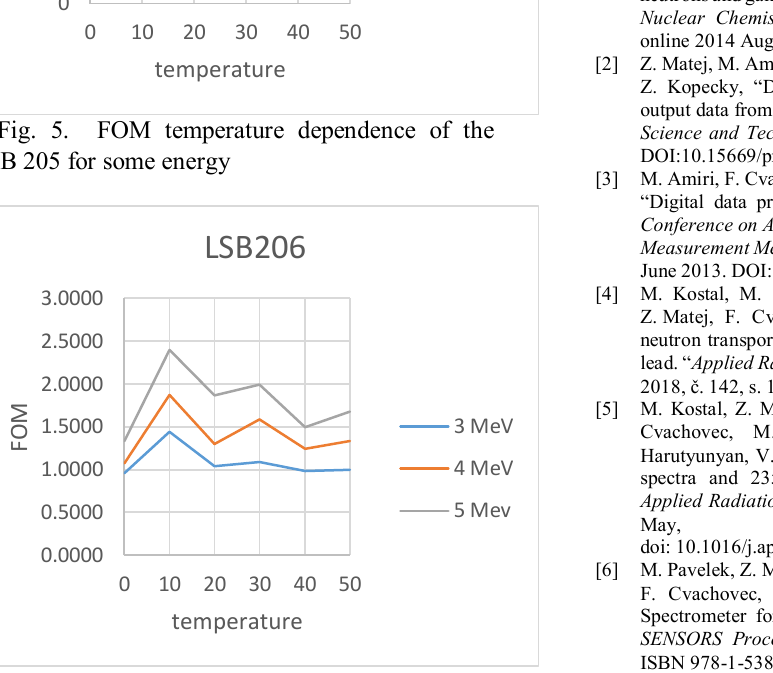
Fig. 6. FOM temperature dependence of the